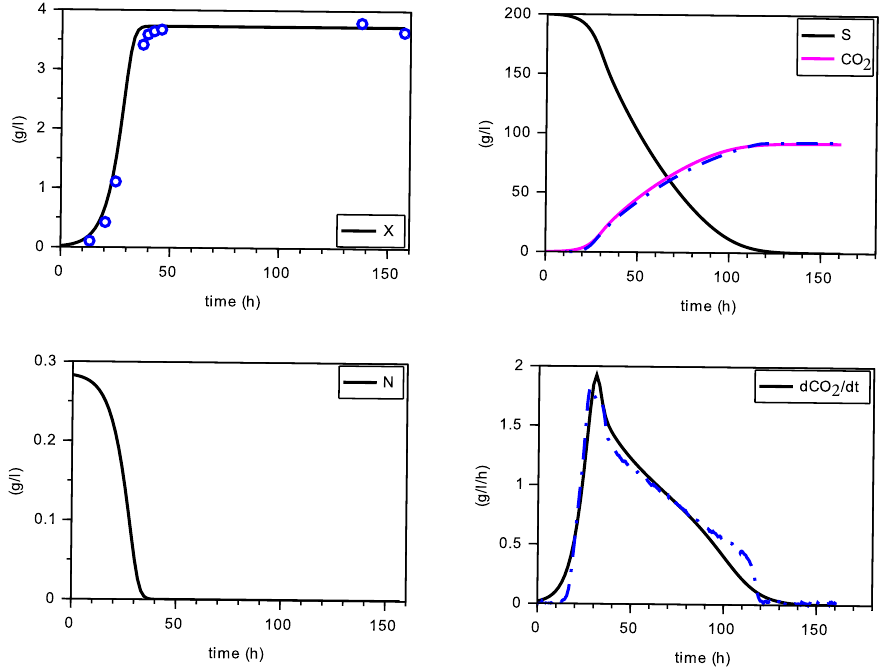
Figure 15. Simulation for N ( 0 ) = 0.283 g · L − 1 (experimental data in